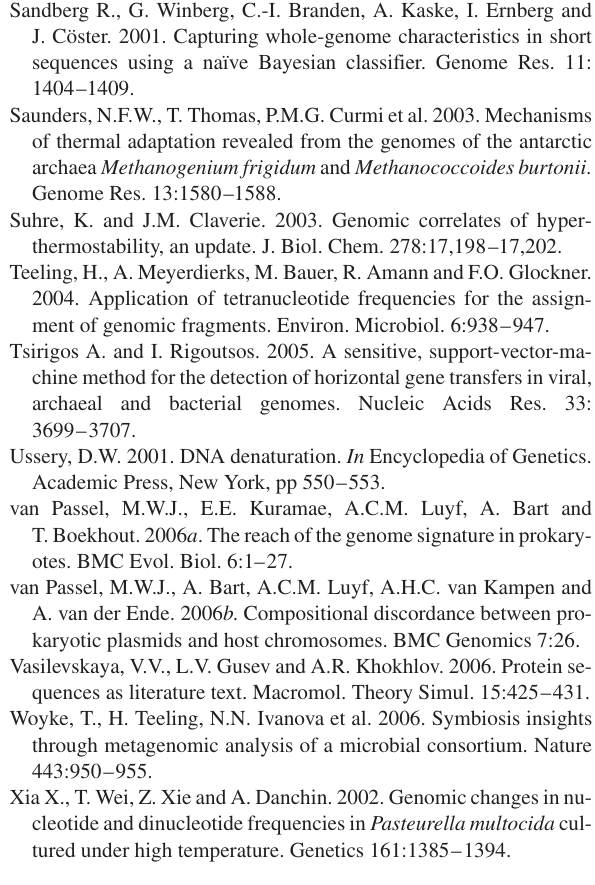
Supplementary Table S2. Classification and regression tree analysis results using four oligonucleotide frequency lengths over the entire virtual coding strand to classify organisms into two temperature optimum ranges, hyperthermophile versus non-hyperthermophile (hyper vs. non-hyper) and mesophile versus non-mesophile (meso vs. non-meso). Tetramers provide the most effective classification scheme considering both models built. Model-with-all is the number of misclassifications when building a model using all 195 genomes. Leave-one-out is the number of mispredictions when classifying an organism against a model built using the other 194